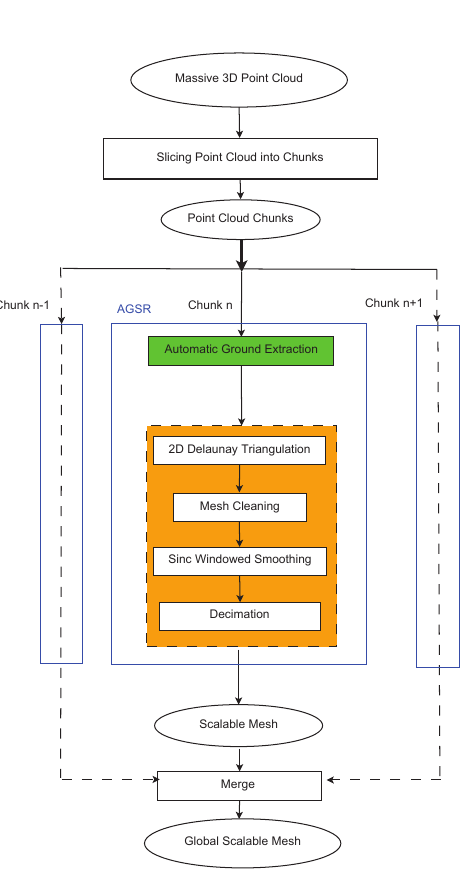
Figure 1: The workflow of the proposed Automatic Ground Surface Reconstruction (AGSR) framework designed to be inte- grated within a global parallel computation scheme dedicated to massive 3D point cloud